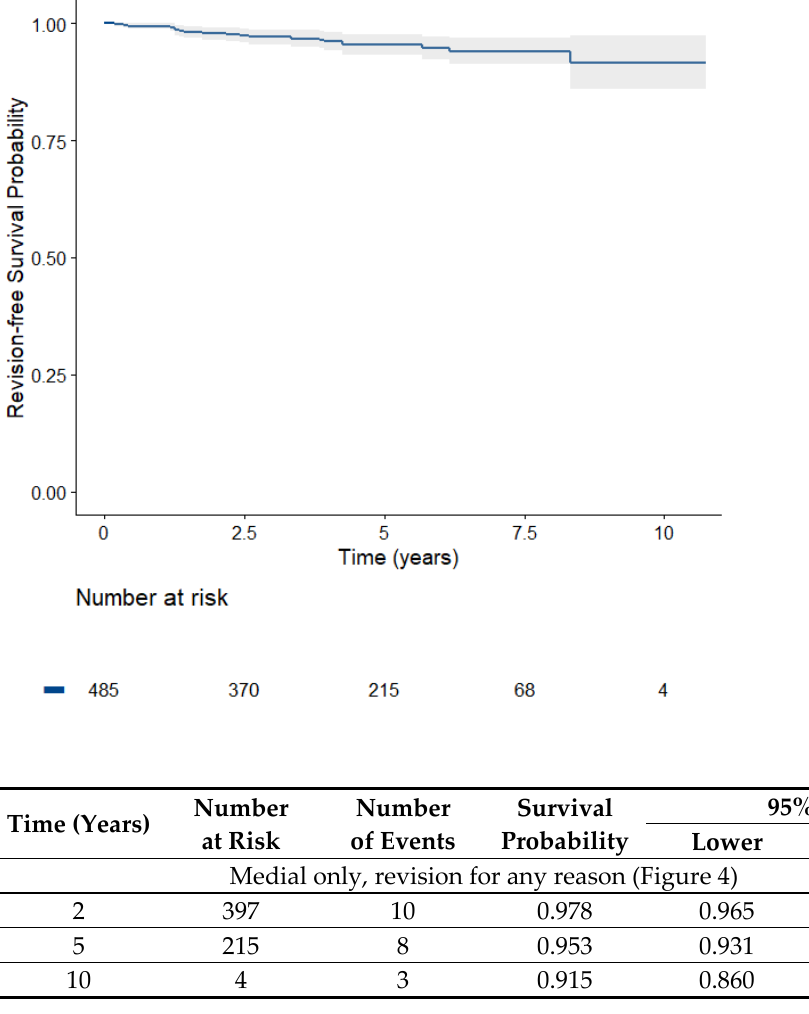
Figure 4. Kaplan-Meier survival analysis of the medial UKAs (485 medial unicondylar knee prosthesis) over time (overall survival with revisions for any reason).